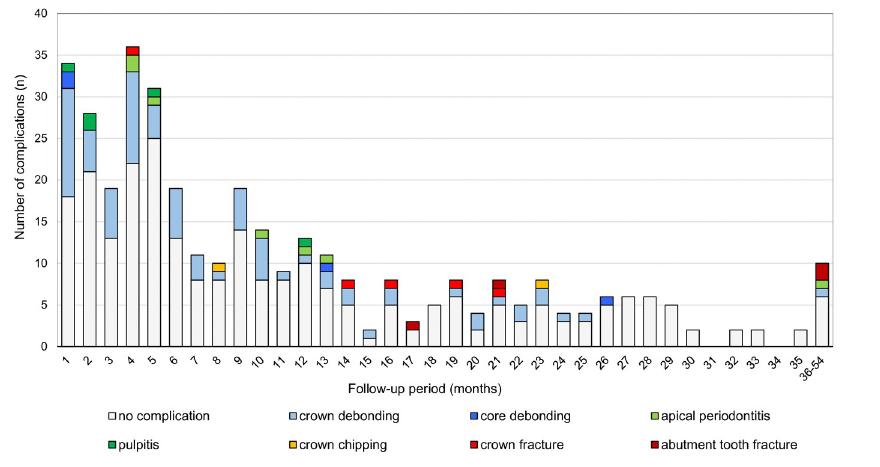
Fig 3. Timeline and types of complications of CAD/CAM composite